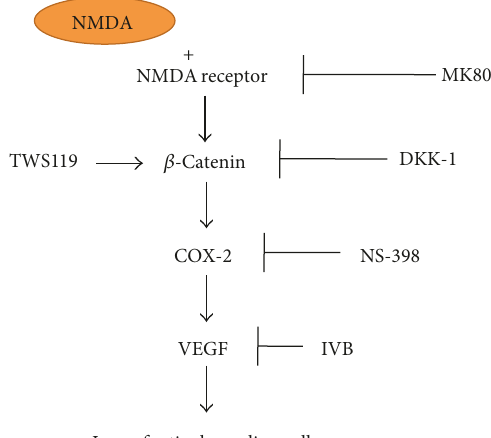
Figure 7: Schematic graph illustrating the involvement of Wnt/ β -catenin, COX-2, and VEGF in retinopathy induced by